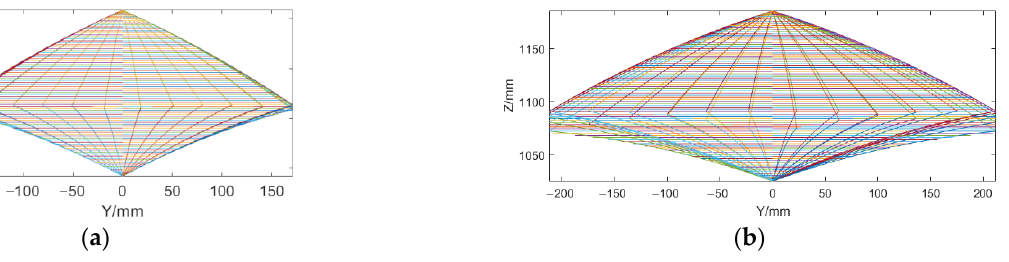
Figure 16. Projection of the workspace on the yoz plane: ( a ) Before optimization; ( b ) After optimi- zation.